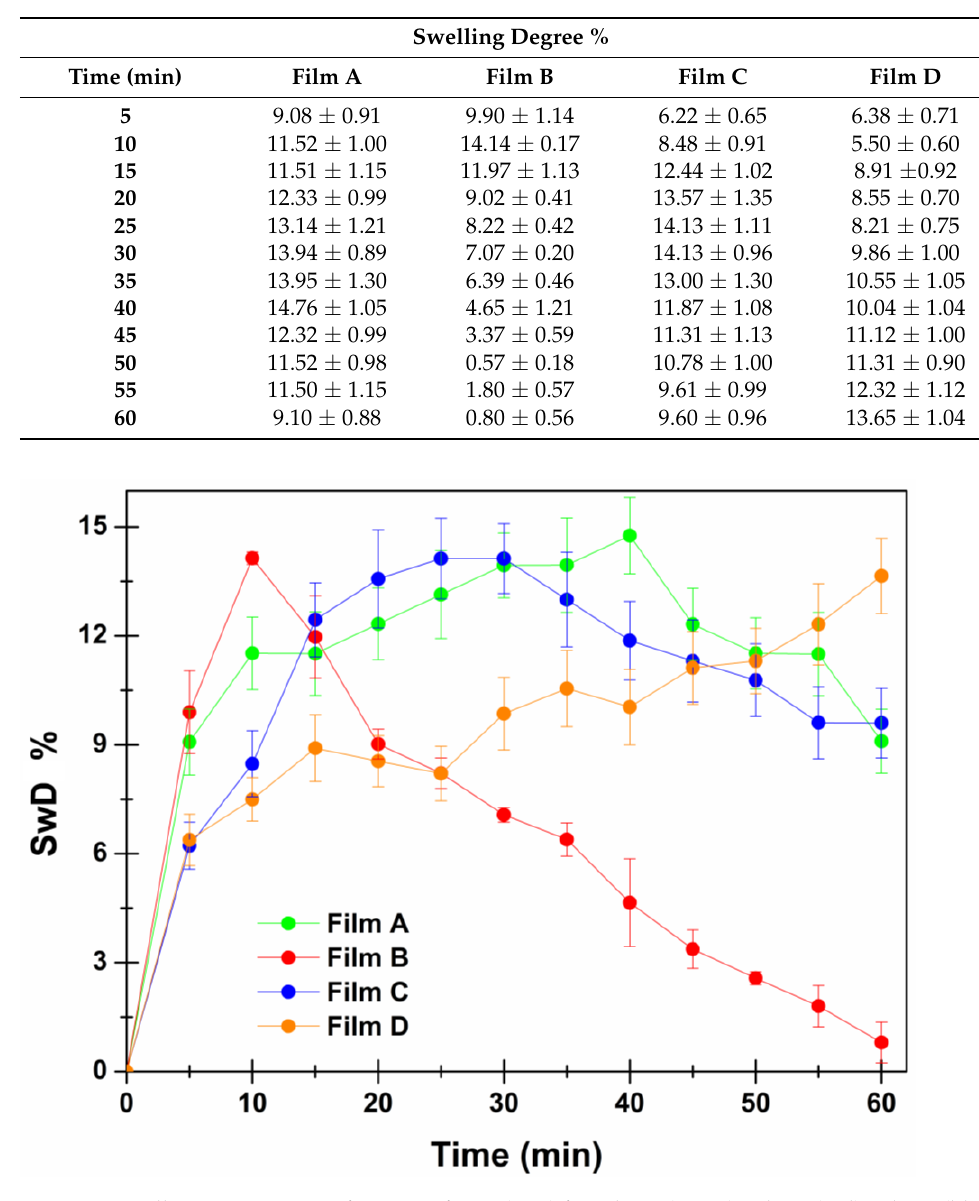
Figure 4. Swelling Degree % as a function of time (min) for Film A (green), Film B (red), Film C (blue), Film D (orange). Data are report ed as means ± SE (n = 3). Table 5. Swelling Degree % data reported as means ± SE (n = 3) .